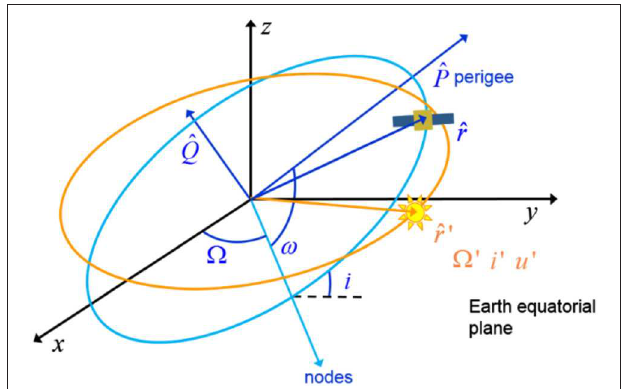
FIGURE 1 | Geometry of the third body with respect to the spacecraft and the central